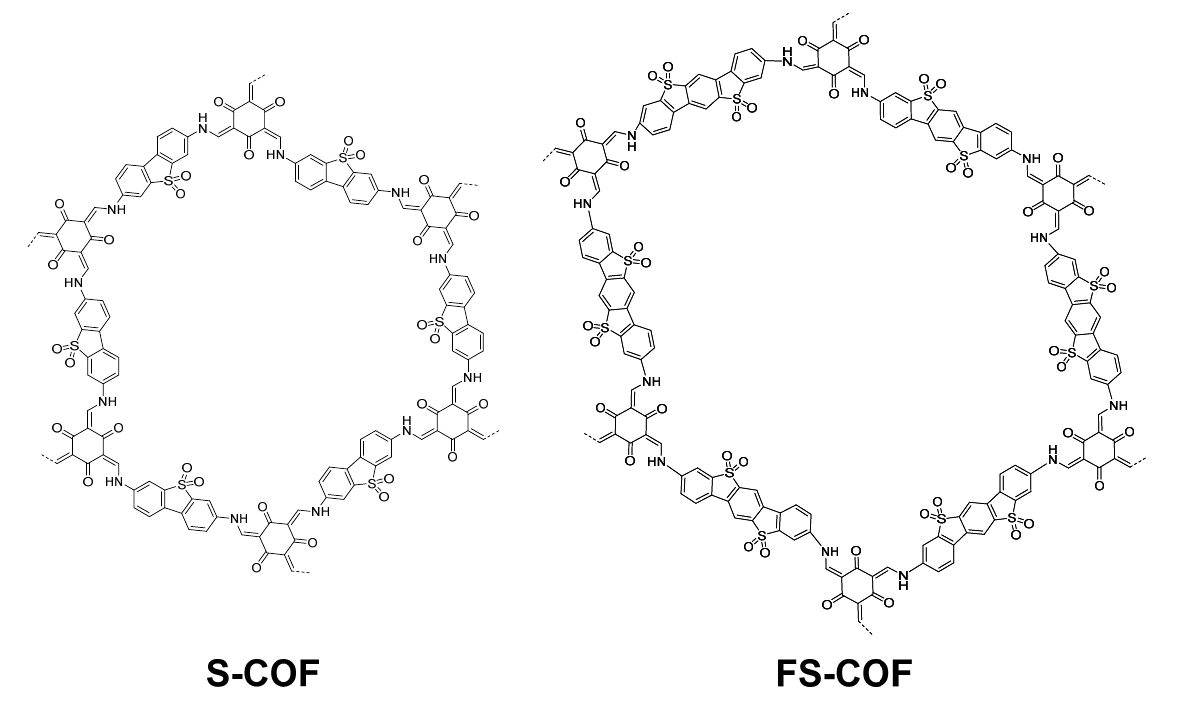
Figure 31. Sulfone-containing COFs, S-COF, and FS-COF structure [143]. Whilst linkers such as imine functionalities are useful functional groups, they are nevertheless not completely inert to hydrolysis especially in non-neutral pH